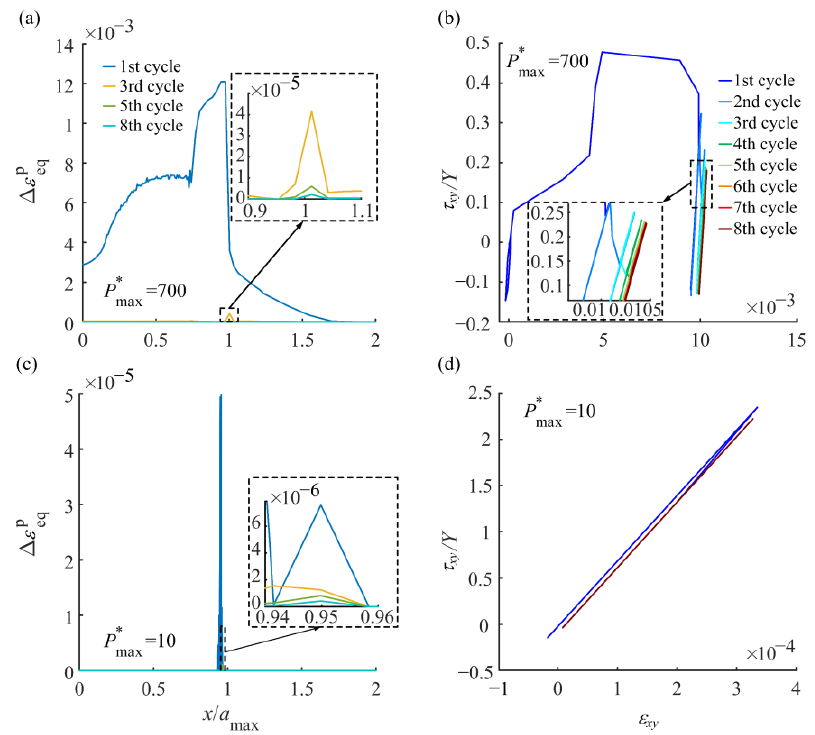
Figure 5. ( a ) ∆ ε p eq on the sphere surface after unloading, and ( b ) shear stress–strain response of the point at the edge of A max in eight loading cycles, where P * max = 700. ( c , d ) The same content as in ( a , b ), where P * max = 10.